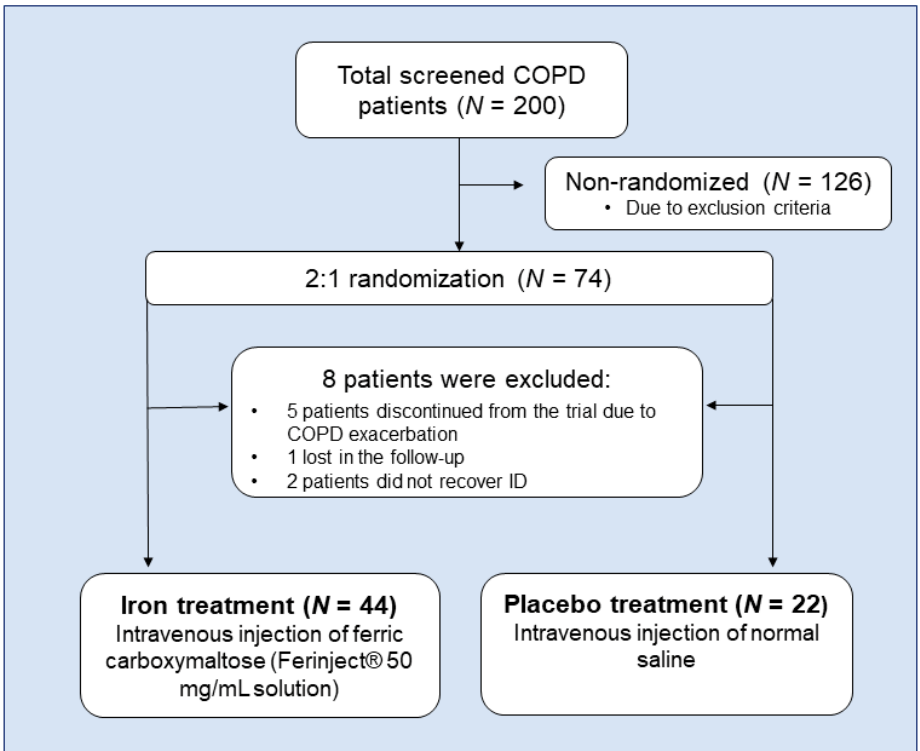
Figure 1. Flowchart of the FACE trial according to CONSORT guidelines. Definition of abbreviations: COPD, chronic obstructive pulmonary disease; ID, iron deficiency.